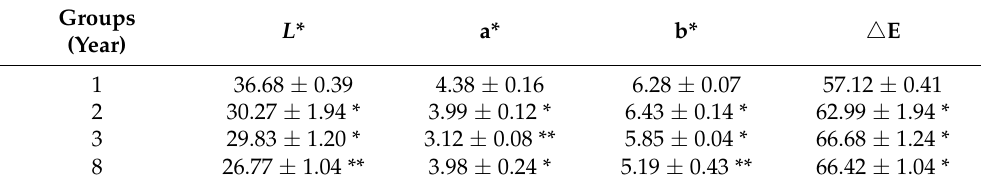
Table 2. Color analyses of shrimp paste samples during 1, 2, 3, and 8 years of fermentation.